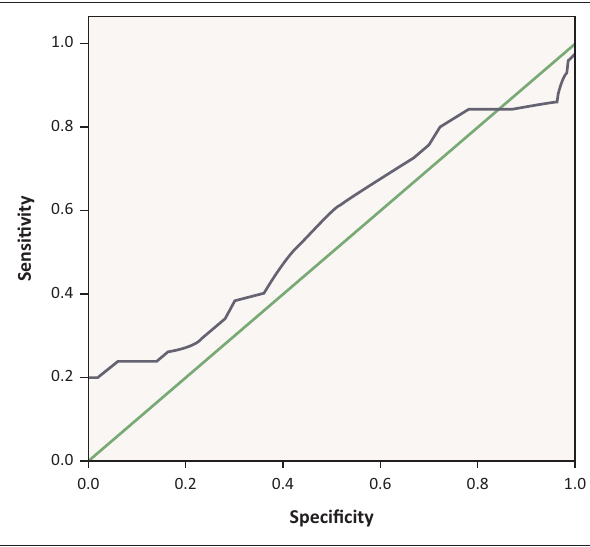
FIGURE 2: Receiver operating characteristic curve analysis to evaluate red blood cell distribution width utility in discriminating between irritable bowel syndrome patients and healthy controls, Babol, Iran,